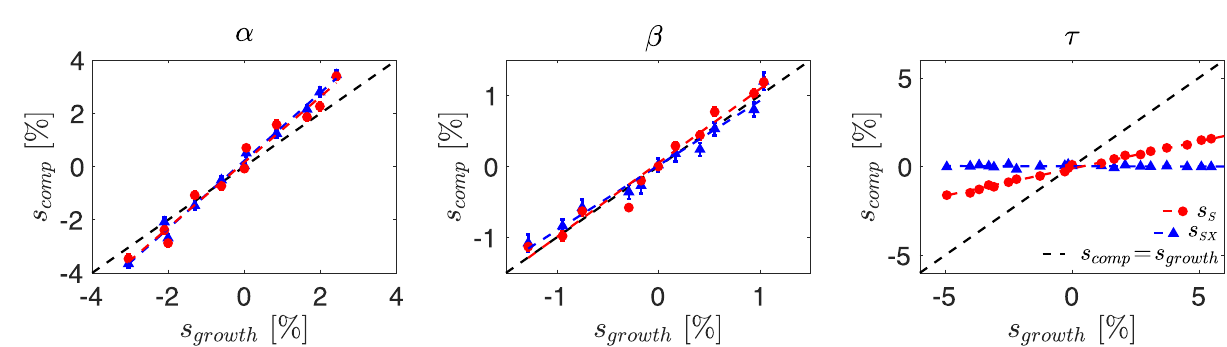
Fig 4. Competitive vs isolated selective advantage. The selective advantage in a competitive setting s s growth , when changing adsorption rate α , burst size β and lysis time τ . Straight line fits are shown as dashed lines, with gradient σ such that s comp = σs growth . From the above data we find σ S α = 1.2324, σ SX α = 1.2764, σ S β = 1.0432, σ SX β = 0.9134, σ Sτ = 0.3057 and σ SXτ � 0. Resident parameters used were α = 3 × 10 − 6 , β = 100 and τ = 15. As before δ = 0.1 and B 0 = 1000. s growth determined from 500 simulations, and s comp determined from 200 simulations. Error bars are given by the standard error on the mean of the simulations. Error bars on x axis have been omitted for clarity, but are shown in S2 Fig.